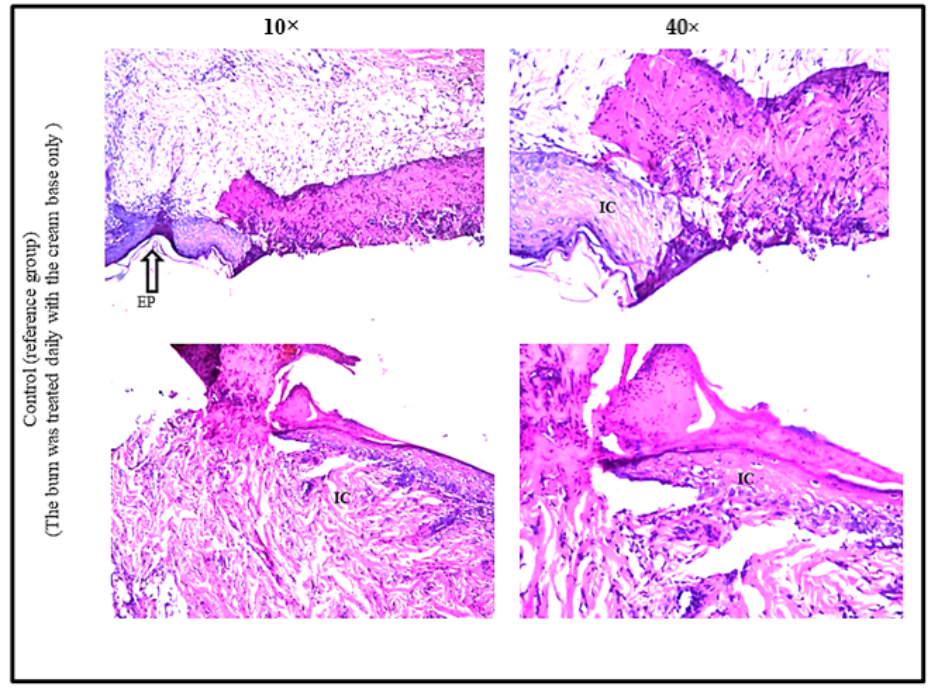
Figure 8. The representative photomicrographs of burned areas from two different rats of control group (treated daily with cream base only) stained with hematoxyline eosin on the seventh day of burn induction. Photomicrographs were taken at magnifications of 10× and 40×. Ep, epidermis; IC, inflammatory cells.